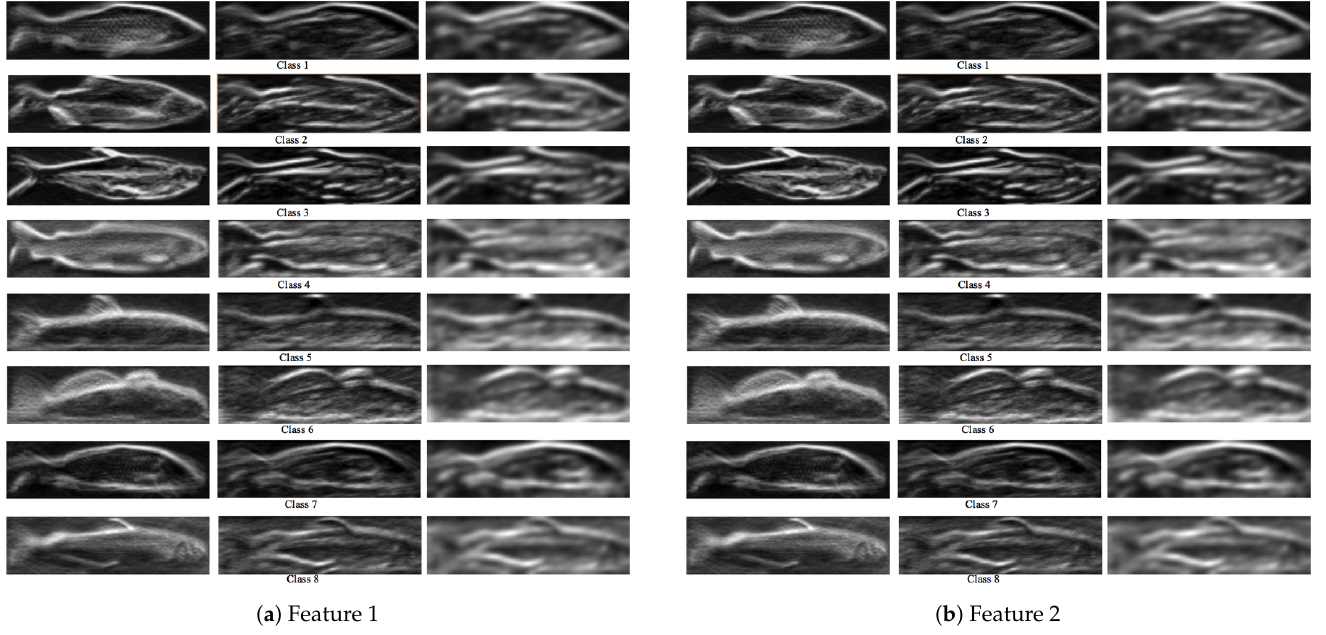
Figure 11. Visualization of features that are learned from the BYU Fish dataset. Both features have 3 transforms. Each row represents a class of the Fish dataset (8 fish species), and each column represents the output of each